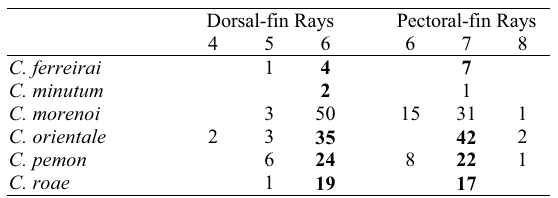
Table 7. Number of specimens of the species of Cetopsidium with cited number of caudal vertebrae. Bold indicates value for holotype when examined.